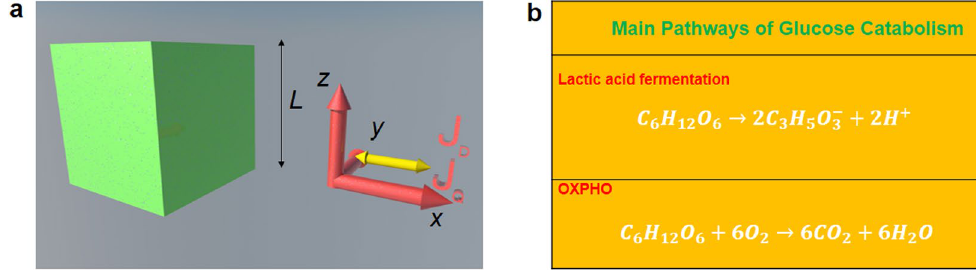
Figure 1. Cell representation and balancing of glucose catabolism. ( a) Sketch of the cubic cell according to the cyto-morphological features of the epithelial tissue chosen as the reference tissue in our theoretical model. ( b) Schematics of main pathways of glucose catabolism. The internal heat flow and the mass diffusion flow start in the cytoplasm region for x = L /2 and are along + x and − x directions as shown by the yellow